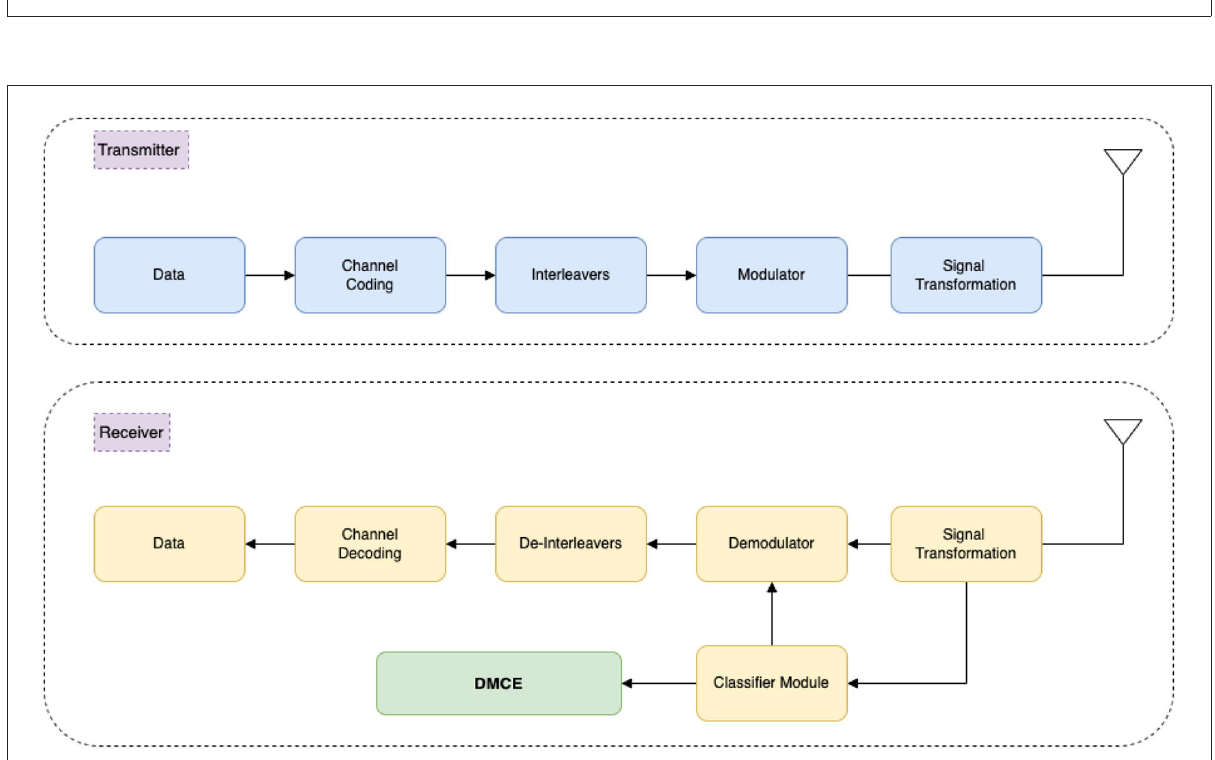
FIGURE2 Our proposed system architecture. It takes constellation data points as image input. This image is fed to a trained CNN whose last convolutional neural network (CNN) layer is used to obtain an explanation shown as explanation visualization.